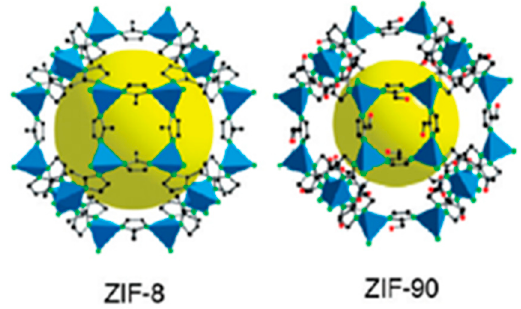
Figure 5. The sodalite topology of ZIF-8 and ZIF-90 [22]. Reprinted (adapted) with permission from Phan, A.; Doonan, C.J.; Uribe-Romo, F.J.; Knobler, C.B.; Okeeffe, M.; Yaghi, O.M. Acc.